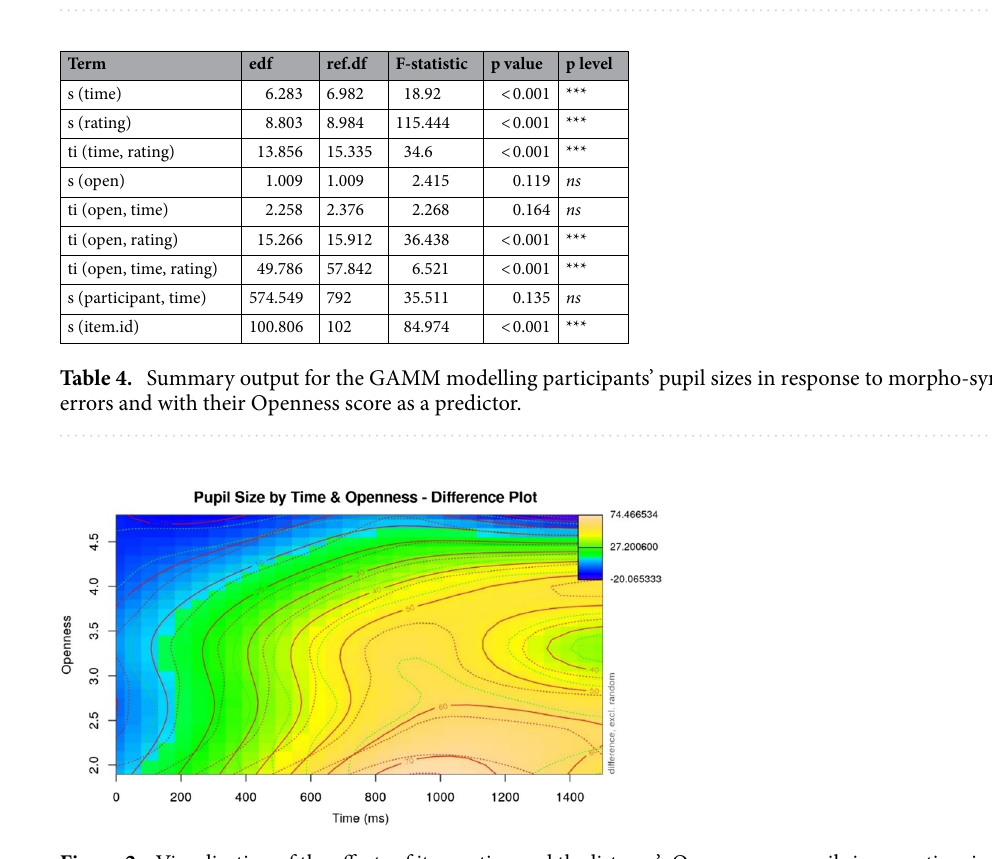
Figure 2. Visualization of the effects of item rating and the listener’s Openness on pupil size over time in response to morpho-syntactic errors. Plot was generated using the itsadug (Version 2.3 63 ) package in